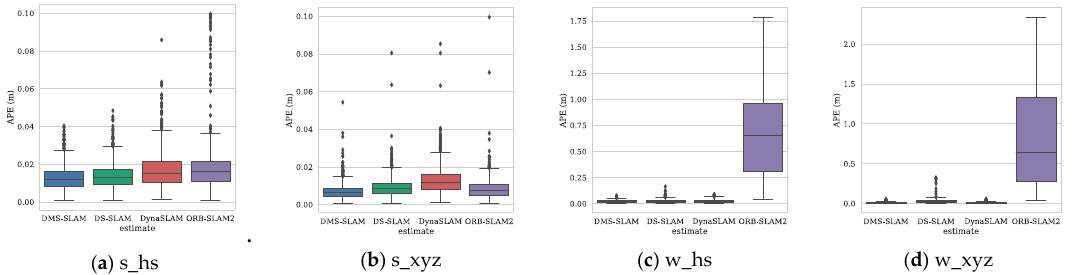
Figure 10. APE distribution of several visual SLAM algorithms obtained in TUM by using low dynamic (s_*) and high dynamic (w_*) datasets. The rectangular portions represent the distribution area of 3/4 APE data, and the other portions represent the distribution area of the remaining APE data. The top of the graph (horizontal line or small black dot) indicates the maximum value of APE and the bottom line represents the minimum.